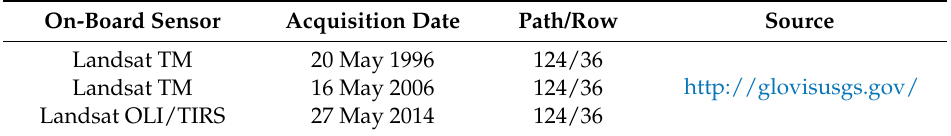
Table 1. Descriptions of Landsat TM and OLI/TIRS images used in this